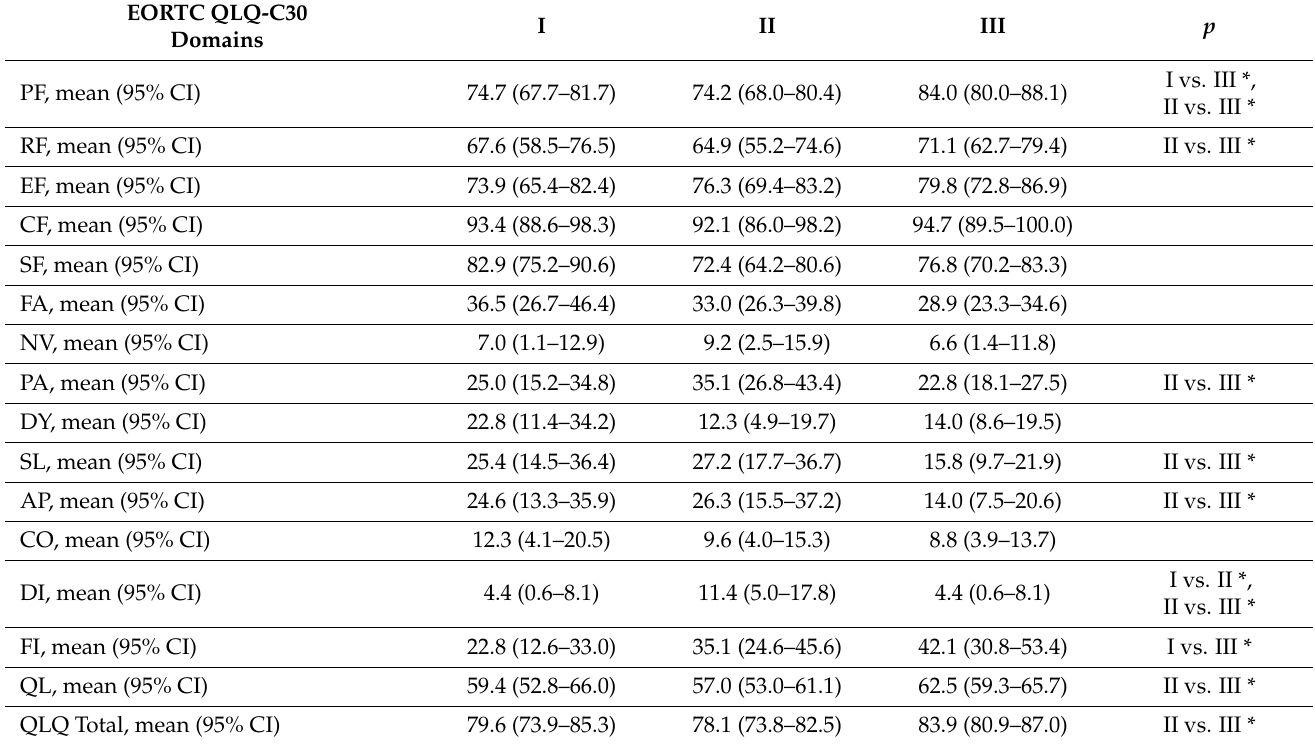
Table 3. EORTC QLQ-C30.